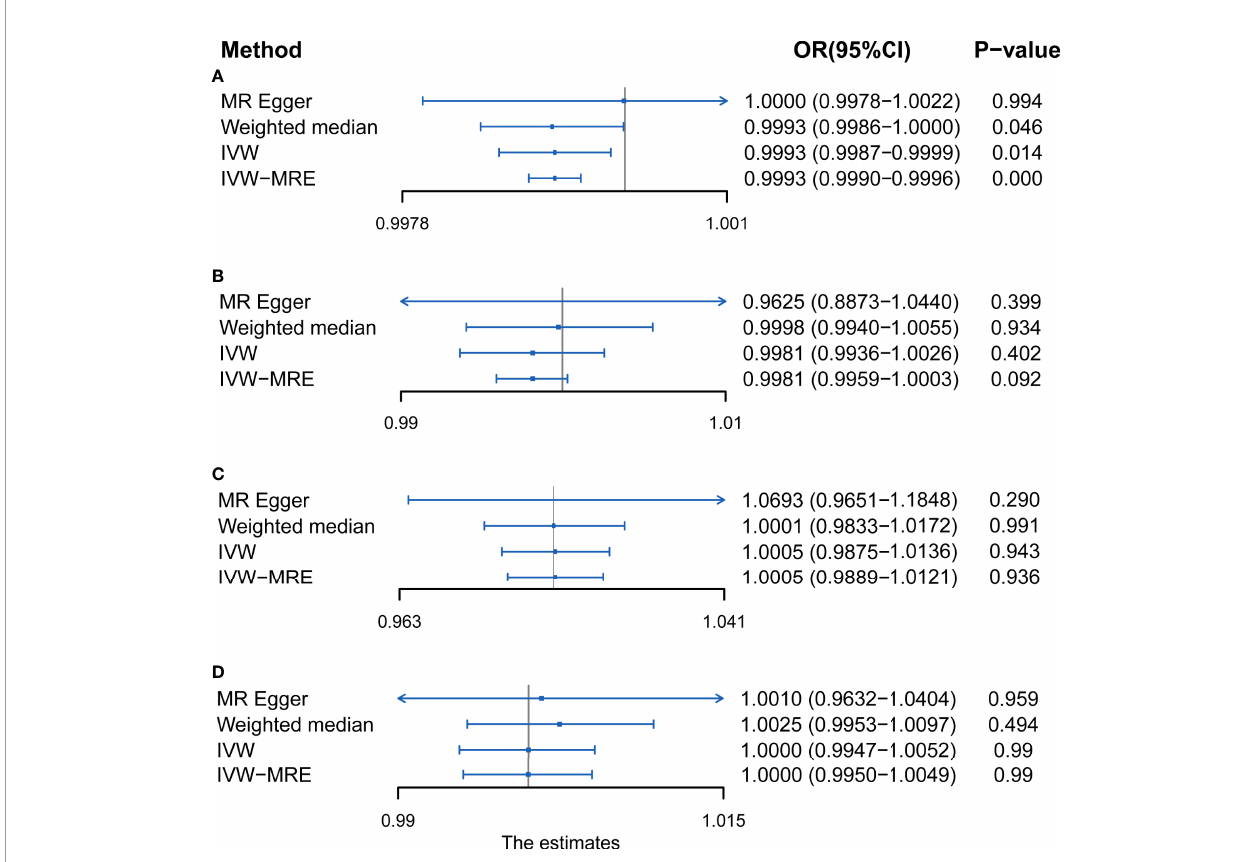
FIGURE 2 | MR results of the association between (A) accelerometer-based physical activity (PA) (average acceleration), (B) accelerometer-based PA (acceleration fraction >425 mg), (C) self-reported vigorous PA, and (D) self-reported moderate-to-vigorous PA with AS risk. OR, odds ratio; CI, con fi dence interval; IVW, inverse variance weighted; IVW-MRE, inverse variance weighted (multiplicative random effects).